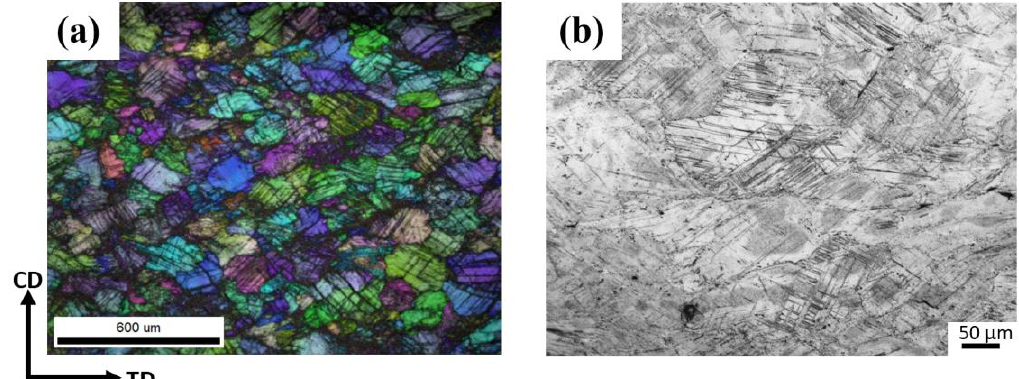
Figure 10. ( a ) The IPF map and ( b ) metallography at